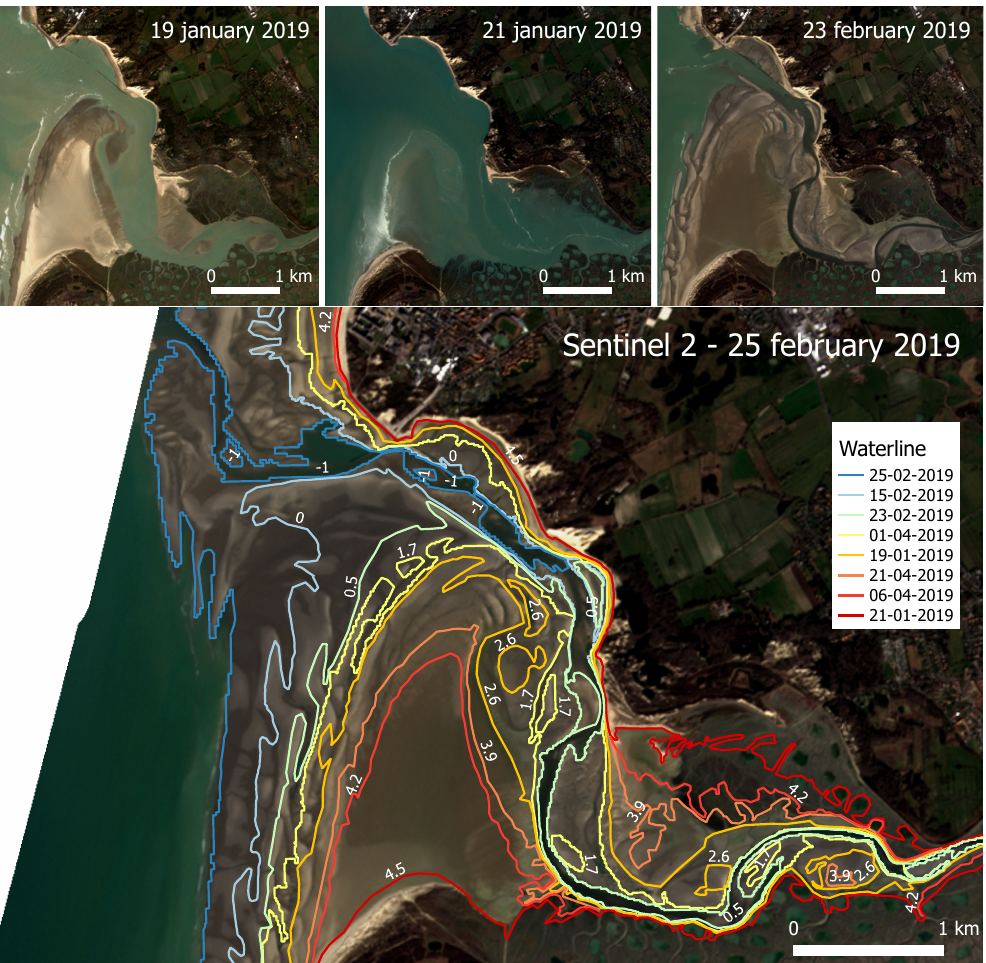
Figure 6. Sample of Sentinel-2 satellite images of various tides and waterlines extracted from these images. Labels refer to the height(m) assigned to each